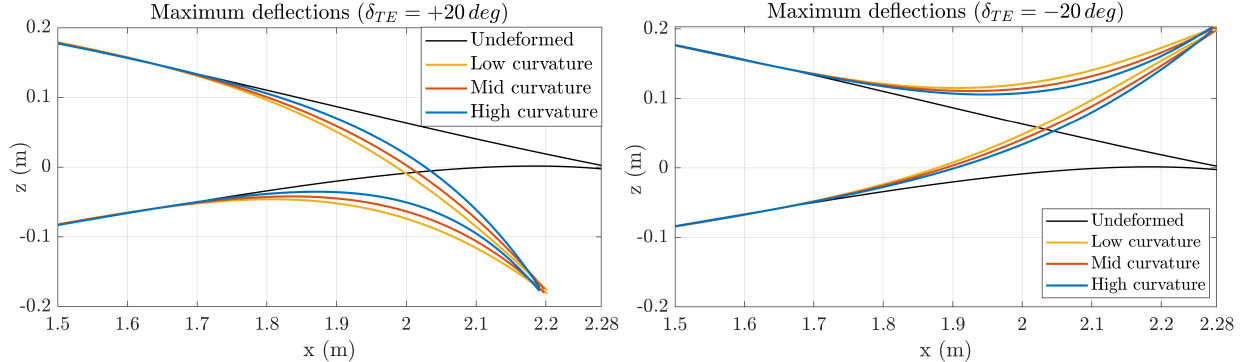
Figure 14. Maximum morphing deflections.